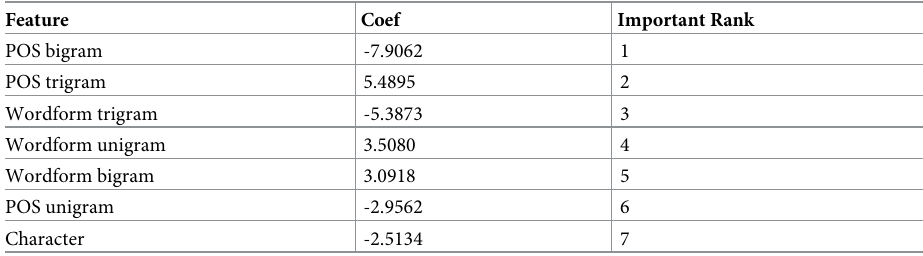
Table 3. Importance coefficient and ranking of features in SVMs model.